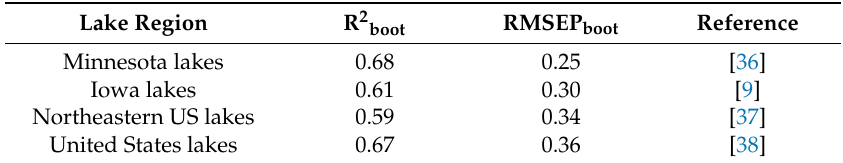
Table 4. Performance metrics (R 2 boot and RMSEP boot ) for transfer functions used to predict total phosphorus from diatom species composition from several regional studies.